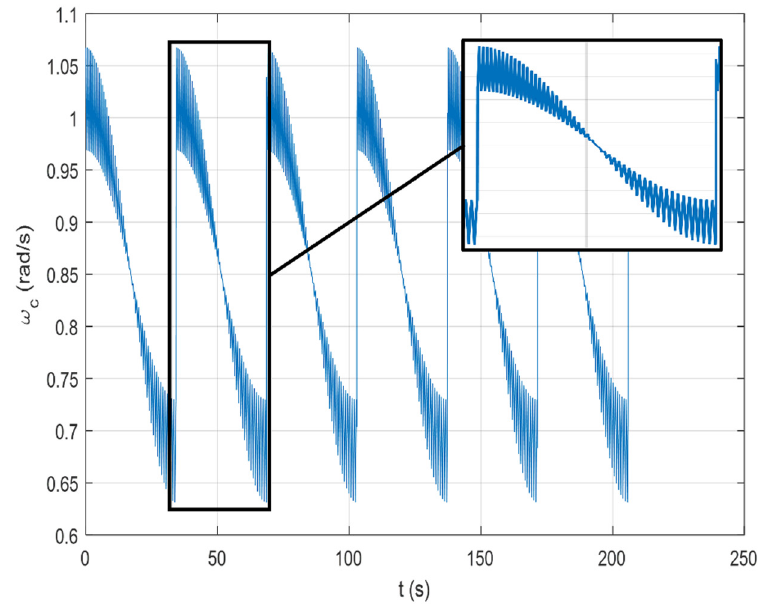
Figure 21. Dual-camera variable speed OCPSI mode: pendulum motion angular velocity.